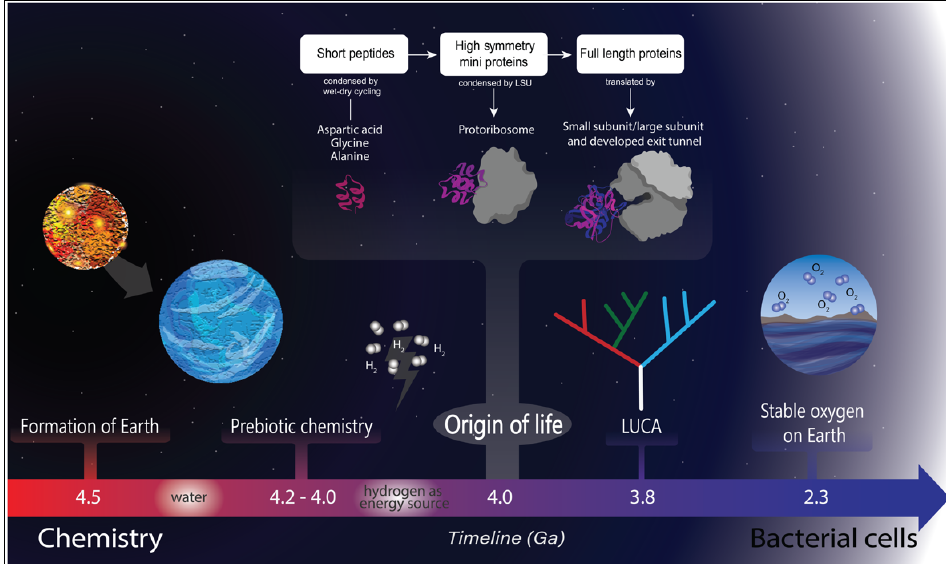
Figure 1. Timeline of life on Earth. Earth was formed around 4.5 Ga, and the presence of water is dated a short time later. Once water was available, a prebiotic chemistry was established, and hydrogen was a likely energy source [23] for life to originate. Life started around 4.0 Ga, characterized by coevolution between peptides (probably originated by wet and dry cycles) and RNA molecules, where the first proto–ribosome arose [24,25]. There are several lines of evidence for the last universal common ancestor at around 3.8 Ga [26], and a more recent event was the great oxidation of Earth that triggered a cascade of adaptations in the extant organisms [27].